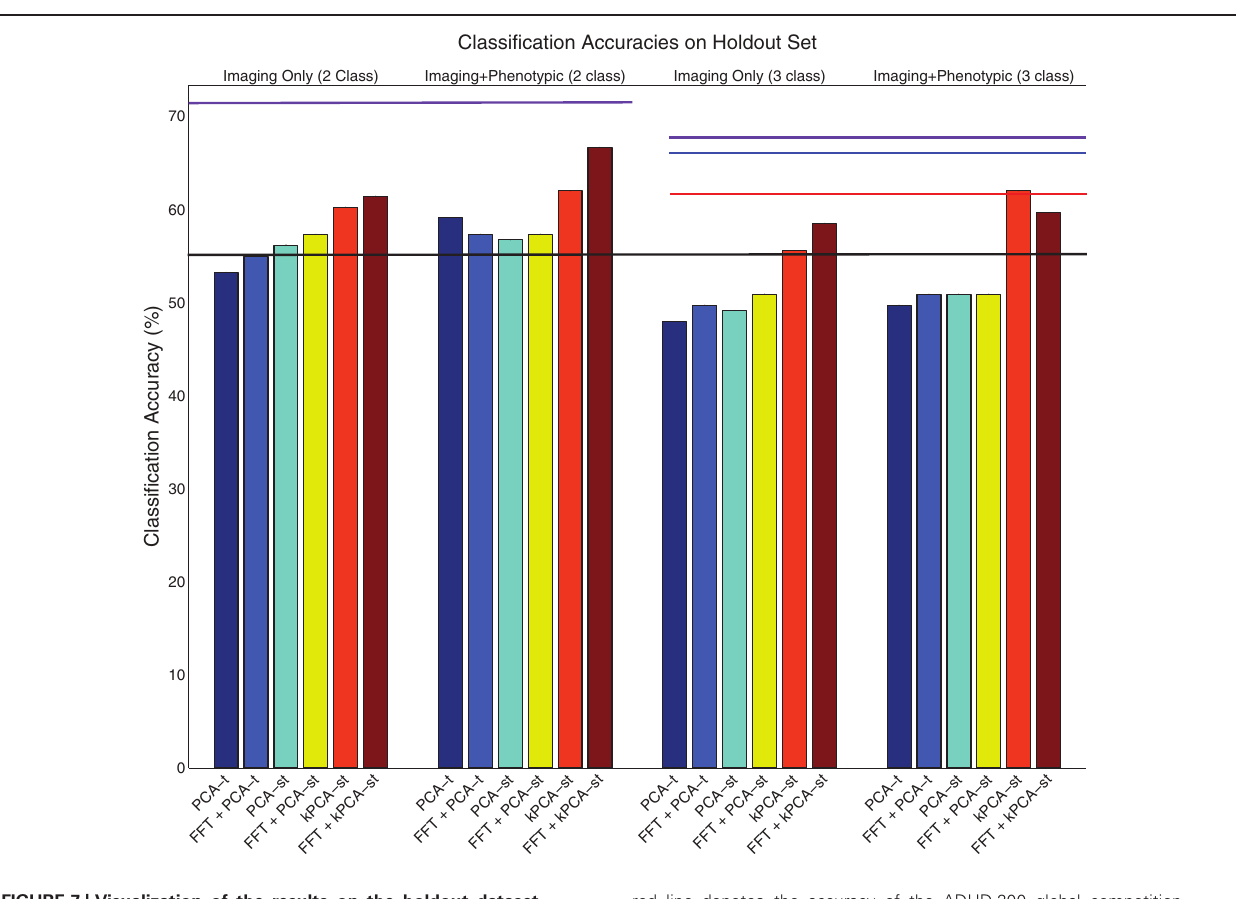
FIGURE 7 | Visualization of the results on the holdout dataset (Table 3). The purple lines denote the phenotypic data classification accuracy in the two class (left) and three class (right) settings. The black line denotes the baseline in both the two and three class settings. The